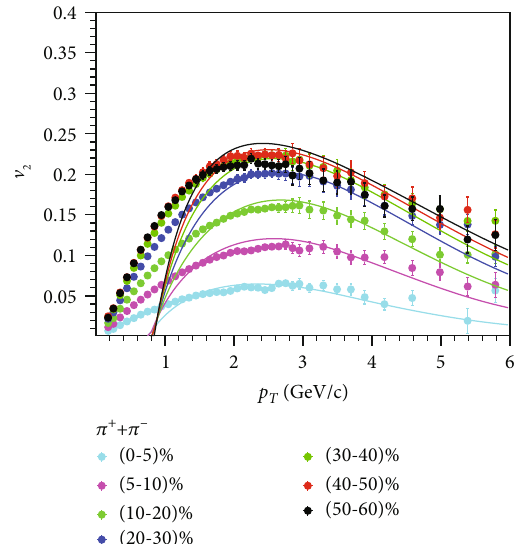
π + + π − ) versus p for various 2 ) of ( ffiffiffiffiffiffiffiffi p T = 2 : 76TeV . Symbols are s NN